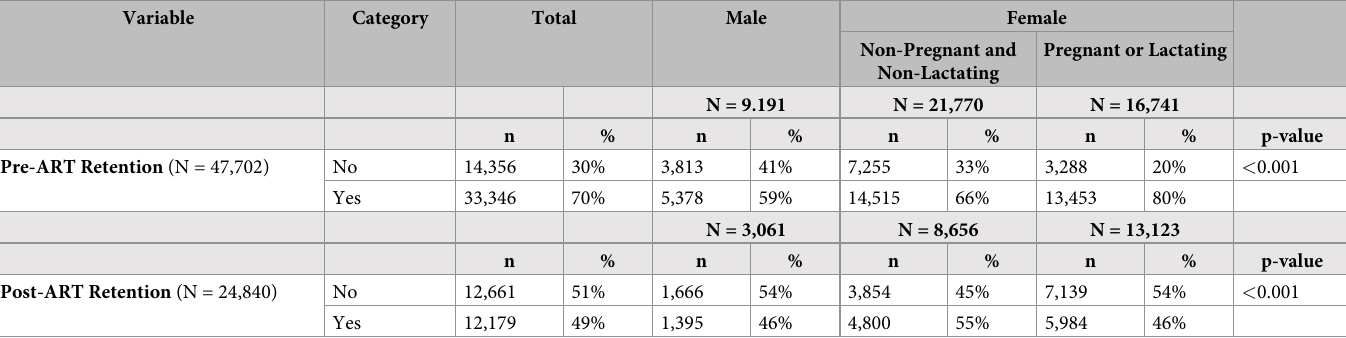
Table 2. Pre- and post-ART retention